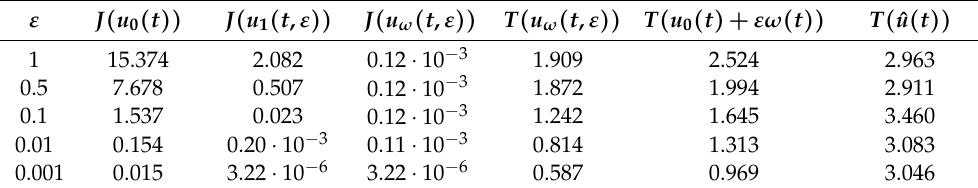
Table 1. Numerical experiments results for various ε